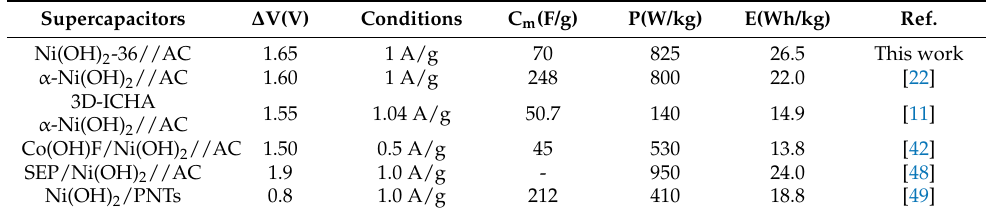
Table 1. Performance comparison of Ni(OH) 2 -based supercapacitors from previous reports.